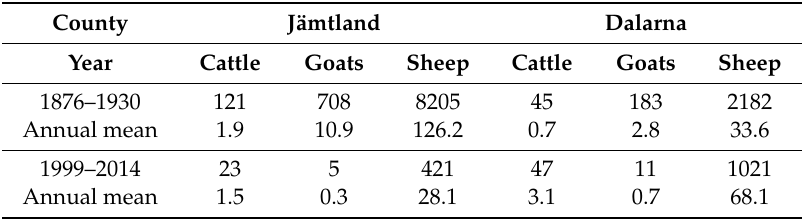
Table 1. Total number of depredated cattle, goats and sheep, during the two periods 1876 to 1930 and 1999 to 2014. The average of depredated animals per year was also calculated as the total number of depredated livestock divided by the length of the time